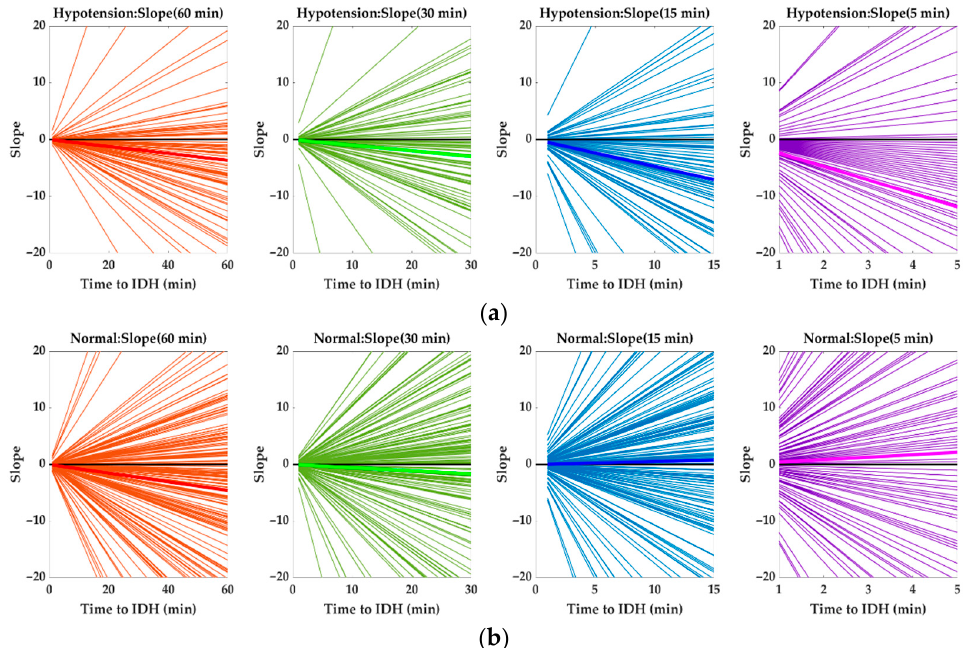
Figure 7. Changes in HR slopes of 1 h, 45 min, 30 min, and 15 min data for IDH and normal (Non ‐ IDH) patients before IDH onset. HR slopes before IDH onset for (a) IDH and (b) normal (Non ‐ IDH) patients. (bold color line: average HR slope, black line: x ‐ axis)